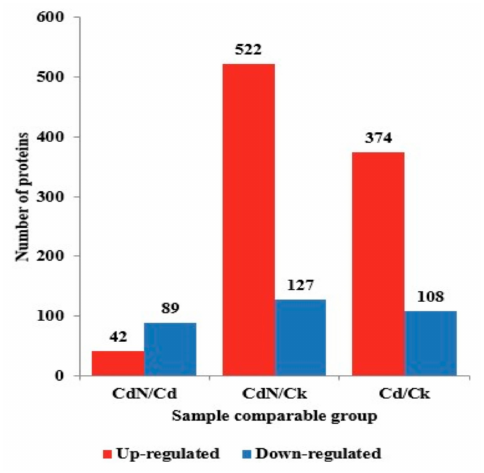
Figure 1. The di ff erentially expressed proteins in the Cd / CK, Cd + N / Cd and Cd + N / CK groups. To characterize the functions of the di ff erentially expressed proteins in the Cd / CK or Cd + N / Cd groups, gene ontology (GO) enrichment-based clustering analyses were performed (Figure 2). When comparing the di ff erentially expressed proteins between the Cd treatment and CK, we found that, in the biological process category (Figure 2A), positive regulation of the protein metabolic process, protein-DNA complex assembly, cellular protein complex disassembly, protein complex disassembly and Golgi vesicle transport were highly enriched among the up-regulated proteins; down-expressed proteins were observed in the regulation of the photosynthetic electron transport chain, cell wall macromolecule and amino sugar catabolic processes. In the molecular function category (Figure 2B), the up-expressed proteins were mainly enriched in their protein binding, alternative oxidase activity, chalcone isomerase activity, chorismate mutase activity and phosphoenolpyruvate carboxykinase activity, while the down-expressed proteins mainly included copper ion binding and tetrapyrrole binding. In the cellular component category (Figure 2C), the up-expressed proteins were mainly enriched in 12 processes, including the cytochrome complex, transporter complex, COP9 signalosome, respiratory chain complex III, mitochondrial respiratory chain complex III, transmembrane transporter complex and others. Down-regulated proteins were primarily located in the photosystem II reaction center, membrane part, photosystem, thylakoid, photosynthetic membrane, thylakoid part, chloroplast thylakoid membrane and